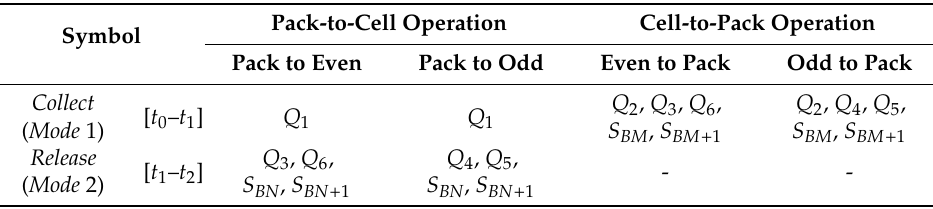
Table 1. On-state switches for balancing